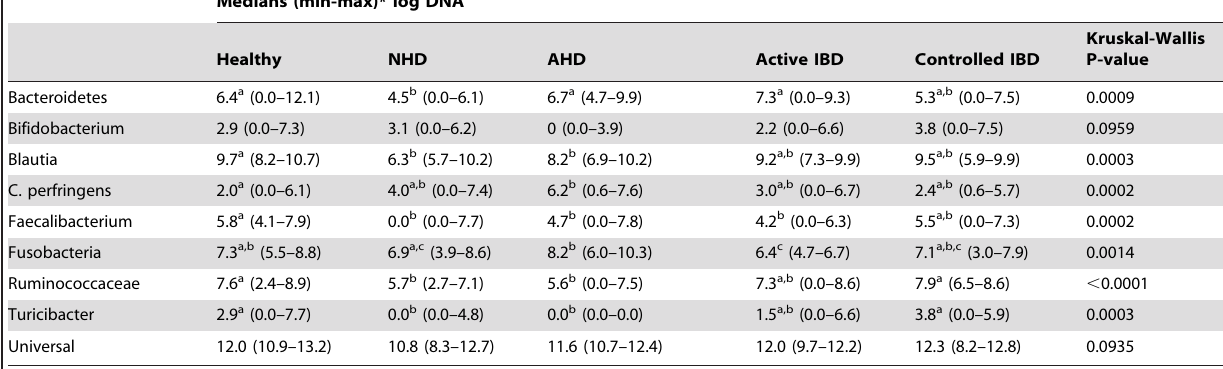
Table 4. Summary statistics for qPCR